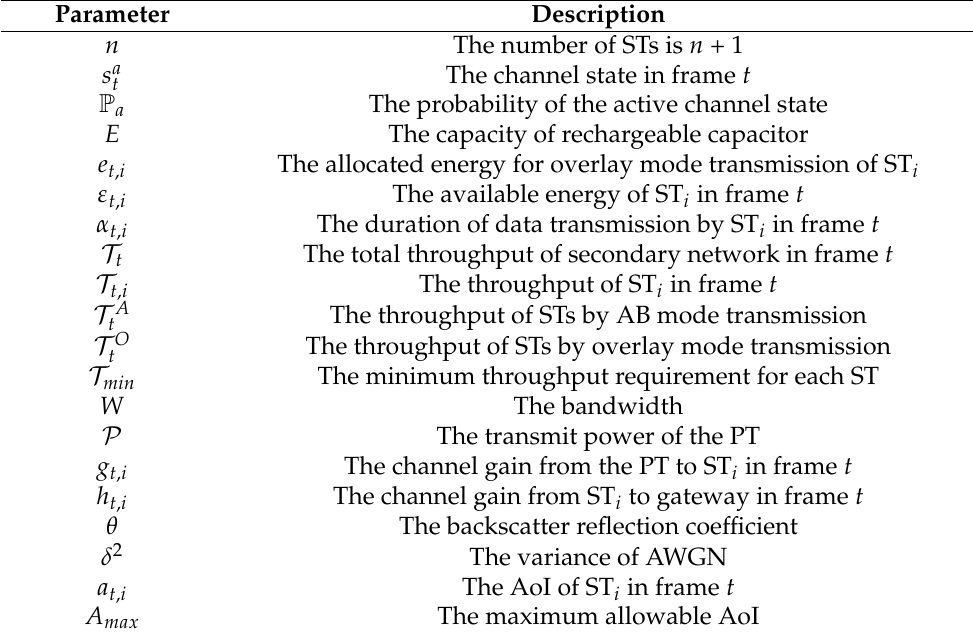
Table 2. Parameter